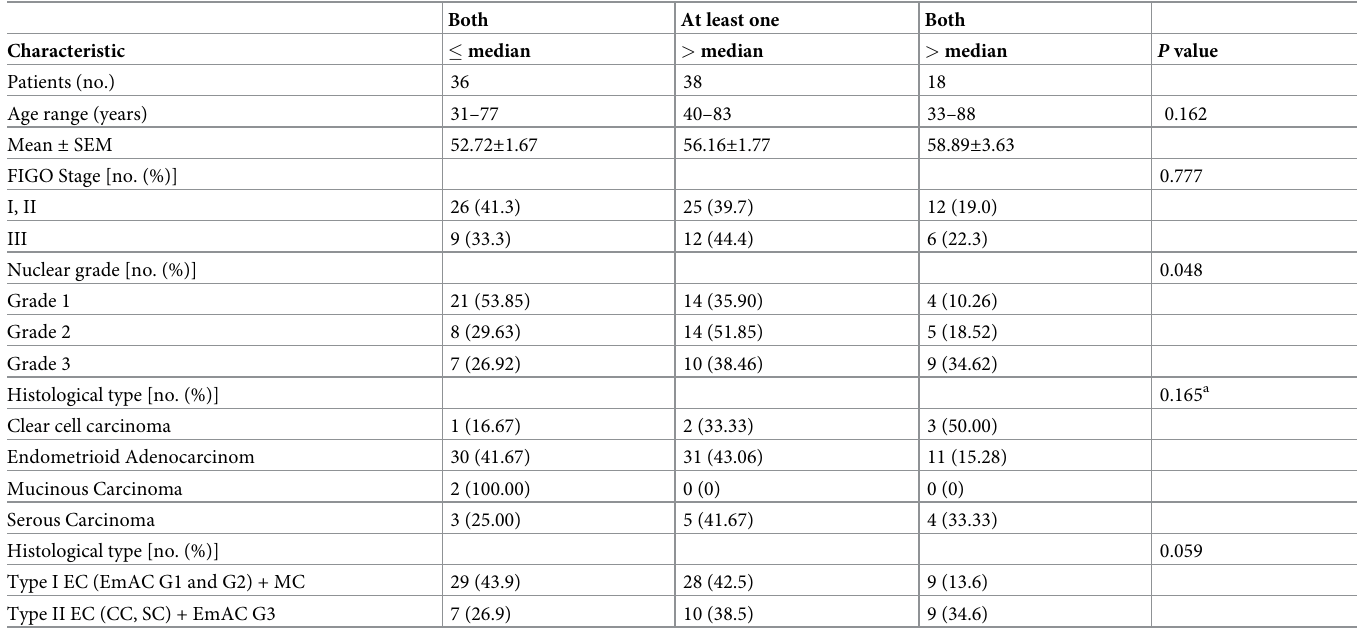
Table 3. Correlation of combination of ALDH1 and CD44 expression score with clinicopathological features in endometrial